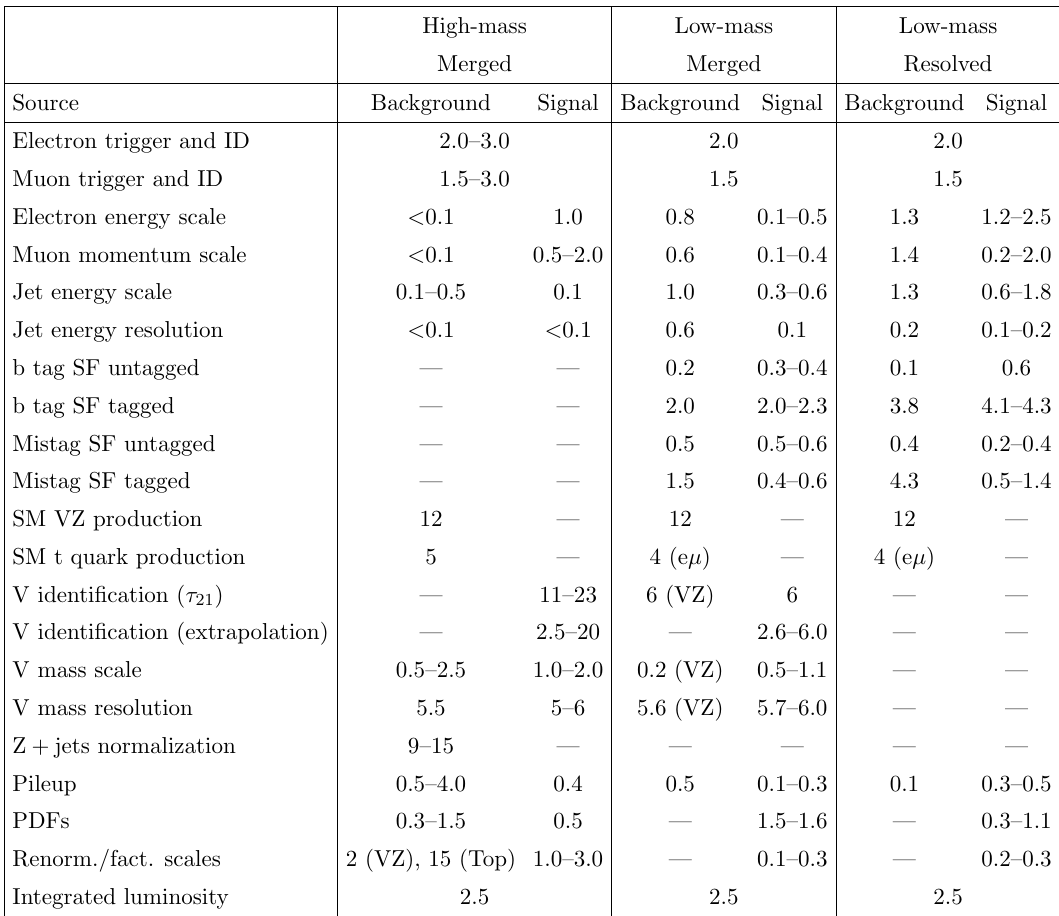
Table 1 . Summary of systematic uncertainties, quoted in percent, a(cid:11)ecting the normalization of background and signal samples. Where a systematic uncertainty depends on the resonance mass (for signal) or on the category (for background), the smallest and largest values are reported in the table. In the case of a systematic uncertainty applying only to a speci(cid:12)c background source, the source is indicated in parentheses. Systematic uncertainties too small to be considered are written as \ < 0.1", while a dash (|) represents uncertainties not applicable in the speci(cid:12)c analysis